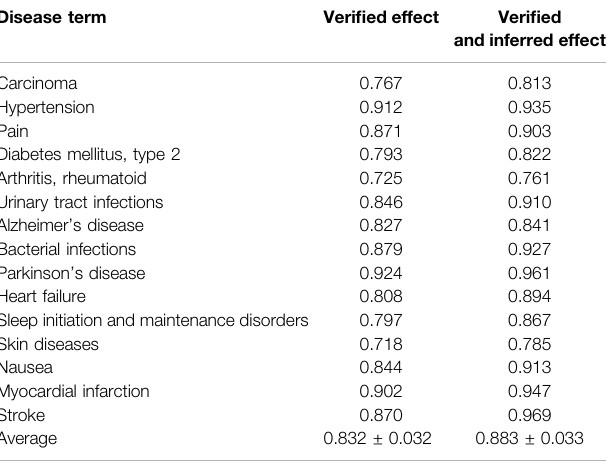
TABLE3| AUROCvaluesofthetrainedmodelsinpredictingthemedicinalusesof natural compounds for 15 diseases using two different test sets. Disease term